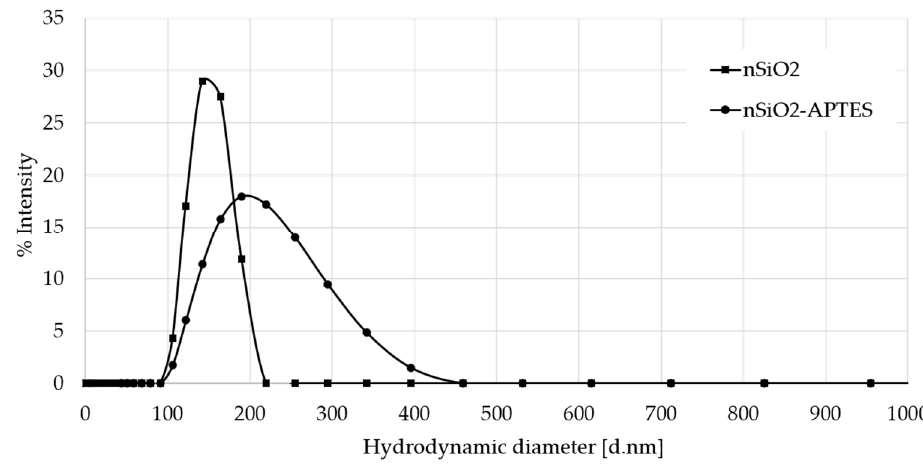
Figure 12. DLS results of nSiO 2 and nSiO 2 -APTES NPs.